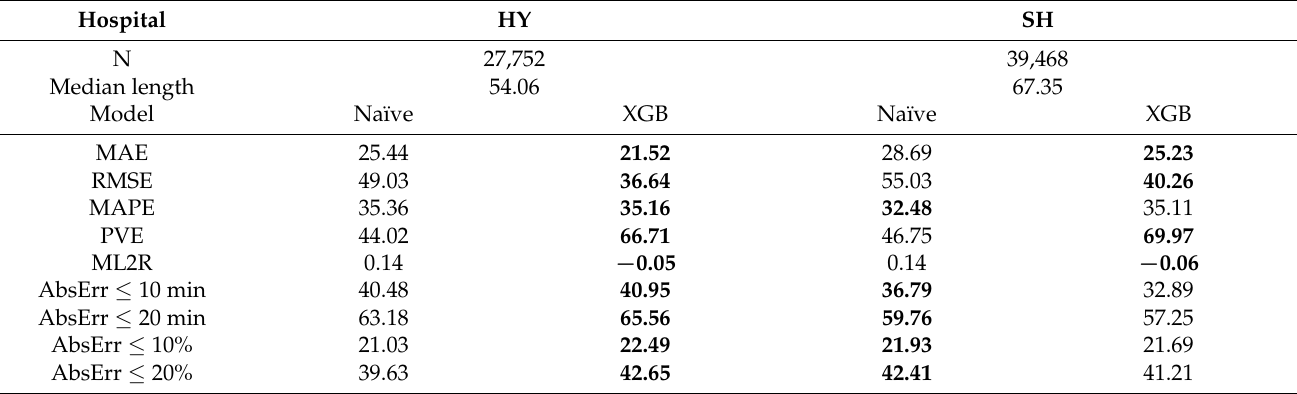
Table 3. Models’ performances on the test set.